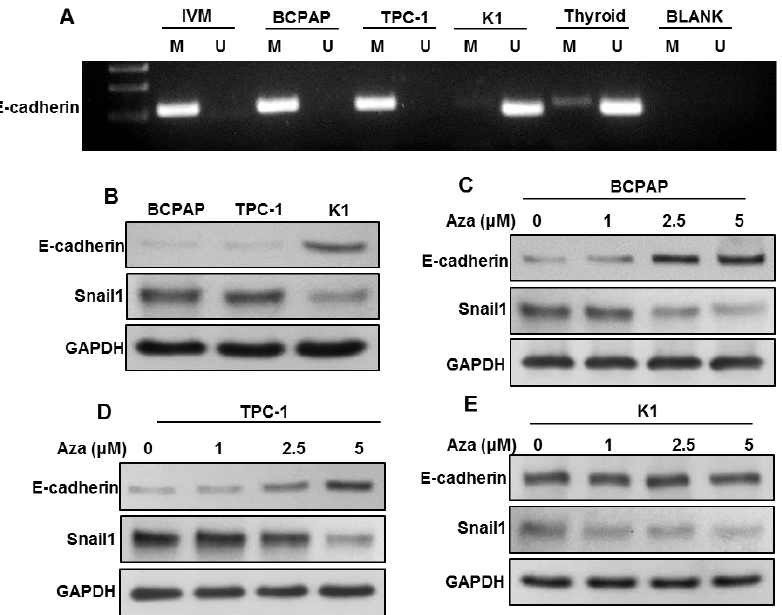
Figure 5. Methylation status of PTC cell lines by MSP for the E-cadherin gene. ( A ) Methylation status of three PTC cancer cell lines assessed by MSP for the E-cadherin gene. MSP analyses of both methylated (M) and unmethylated (U) reactions were amplified from bisulfite-treated DNA and run in a 2% agarose gel. ( B ) E-cadherin and Snail1 protein levels were determined by Western blotting in PTC cell lines. PTC cells were lysed and equal amounts of proteins were separated by SDS-PAGE, transferred to Immobilon membrane, and immunoblotted with antibodies against E-cadherin, Snail1 and GAPDH. ( C , D ) The demethylation restore E-cadherin expression in BCPAP and TPC-1 cells. PTC cells were treated with different doses (1, 2.5 and 5 μM) of 5-aza-2′deoxycytidine for 72 h and cells were lysed. Equal amounts of proteins were separated by SDS-PAGE, transferred to Immobilon membrane, and immunoblotted with antibodies against E-cadherin, Snail1 and GAPDH. ( E ) There was no change in the expression of E-cadherin and Snail1 in K1 cells after treatment with 5- aza-2′-deoxycytidine.